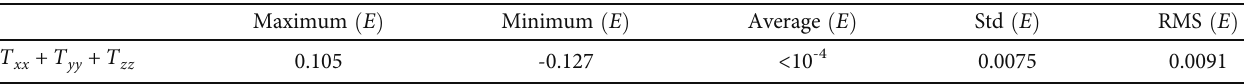
+ T + T , where T is the disturbing gravity gradient xx yy zz